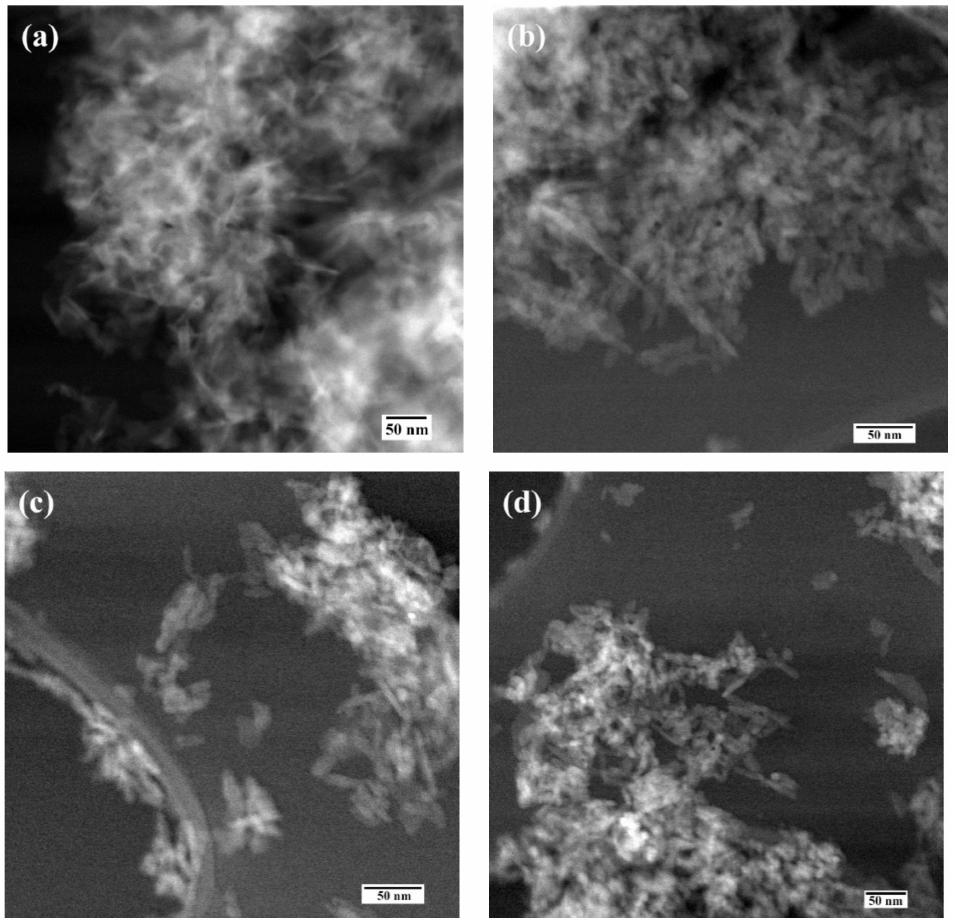
Figure 4. Scanning transmission electron microscopy data of the HA ( a ), Fe-HA3 ( b ), Fe-HA4 ( c ), Fe-HA7 ( d )